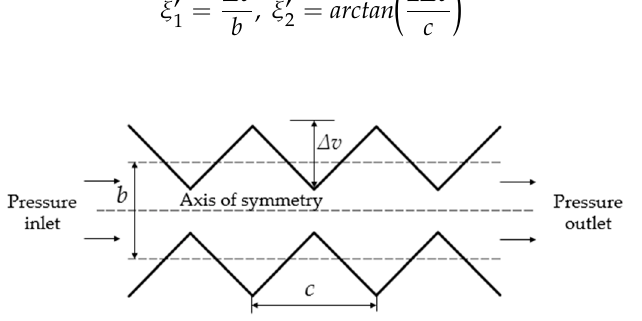
Figure 25. Generalized model of the fracture roughness element.